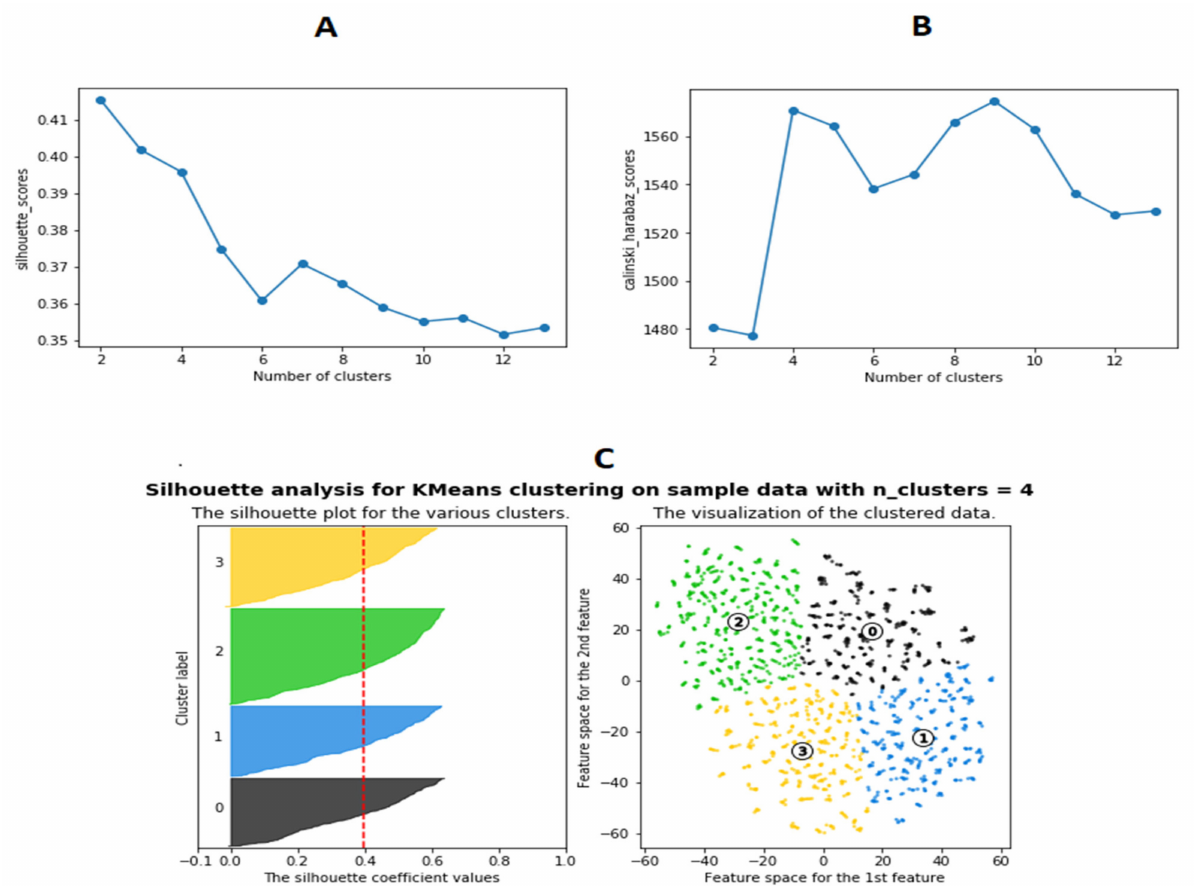
Figure 1. Assessing the optimal number of ADNI Alzheimer’s patient clusters (i.e., AD patient sub-populations) using Silhouette analysis: ( A ) Silhouette scores distributed over cluster sizes; ( B ) Caliniski–Harabaz scores distributed over cluster sizes; ( C ) Silhouette plot and distribution of the data after being clustered with the k-means algorithm. The optimal number of Alzheimer’s patient clusters (or separable sub-populations) was determined to be four.